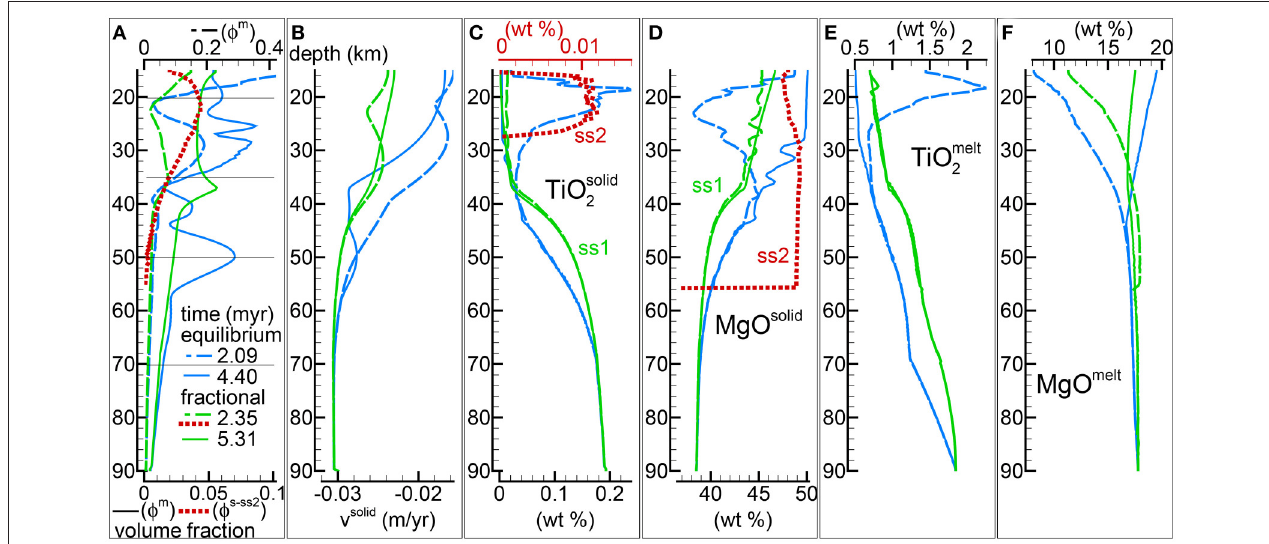
FIGURE 3 | Comparison between dynamic equilibrium melting (DEM) and dynamic fractional melting (DFM). Solid viscosity model: µ s = µ s 0 with µ s 0 = 1 e 21 Pa s, permeability constant C = 1e9 m − 2 . The equilibrium melting simulation is the same as in Figure 4 of MF1 (data file PHASE3-P.YRC4.DAT , zip file max-front1-data.zip ). The data file for the DFM model PHASE3B.YRC1.DAT included in the zip file max-front2-data.zip and an animation ( mf2-movie2.PHASE3B.YRC1.avi ) can be accessed following the link provided in the Supplementary Material. (A) Melt volume fraction vs. depth at 2 different times (solid and dashed lines). Earliest time is approximately defined for the equilibrium melting model by the first arrival of melt at the top, and approximately by the largest amount of melt reaching the top side for the DFM model. Red dotted line is the volume fraction of solid in sub-system 2 at t ≈ 2.35 myr for the DFM model. The black horizontal lines indicate the depths at which the equilibrium mineralogical assemblage has been computed at 2.35 myr in sub-sys 1 and sub-sys 2 after completing the simulation ( Table 2 ). (B) Velocity of the solid matrix. (C–F) Variation of the solid and melt composition (wt %). (C) TiO 2 in the residual solid, for the DFM model the red dotted line refers to the solid in sub-sys 2 (ss2). (D) MgO in the residual solid, including also the solid in sub-sys 2 for the DFM model (ss2, red dotted line). (E) TiO 2 in melt. (F) MgO in